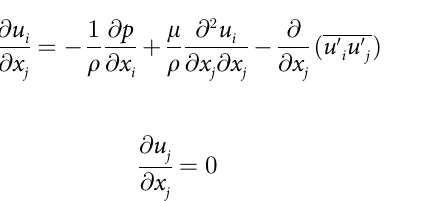
PLOS ONE | https://doi.org/10.1371/journal.pone.0210860 January 30,